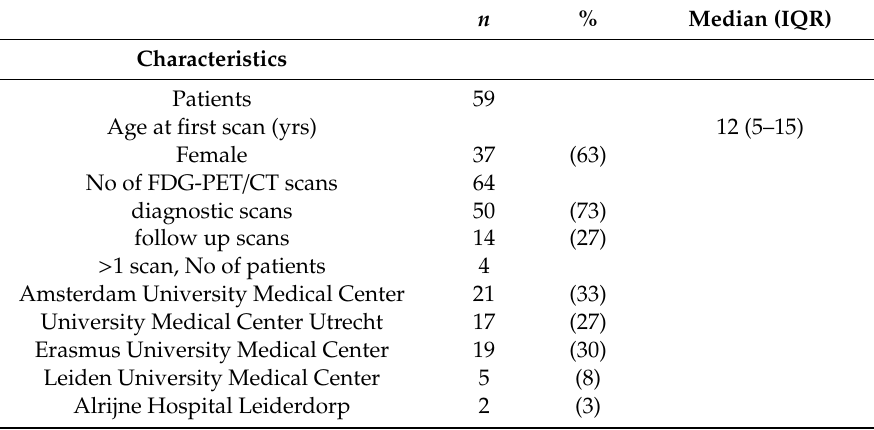
Table 1. Scan and patient characteristics.